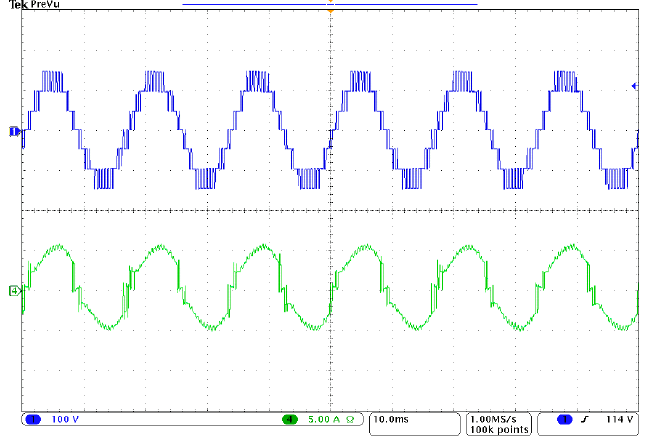
Figure 6. Test results when a nonlinear load is connected to the MPUC inverter. Ch 1 : V ab , Ch 4 : i l .